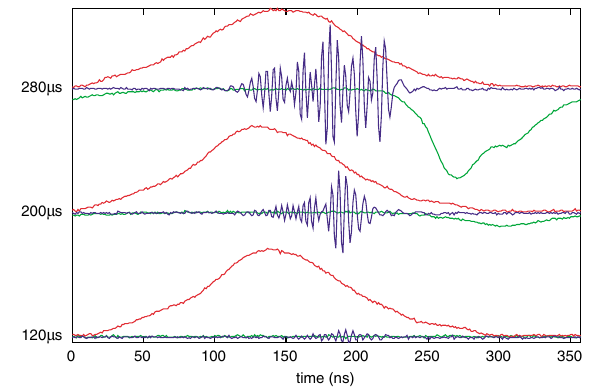
FIG. 2. (Color) Evolution of the instability for a 4 : 4 (cid:16) C = pulse beam. The red trace is the beam current, the blue trace is a vertical beam position monitor difference signal, and the green trace is the electron current into the detector. All traces have the same time reference so one may consider all three detectors to have the same position in the ring. From bottom to top, the traces were obtained 120, 200, and 280 (cid:16) s after the end of accumulation.